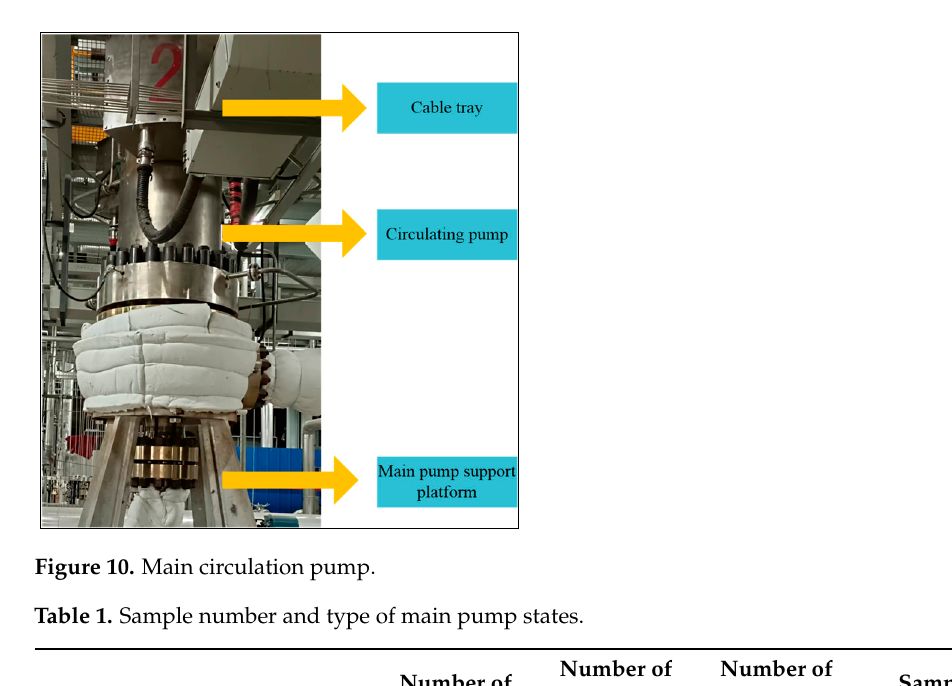
Figure 9. Experimental data collection system.